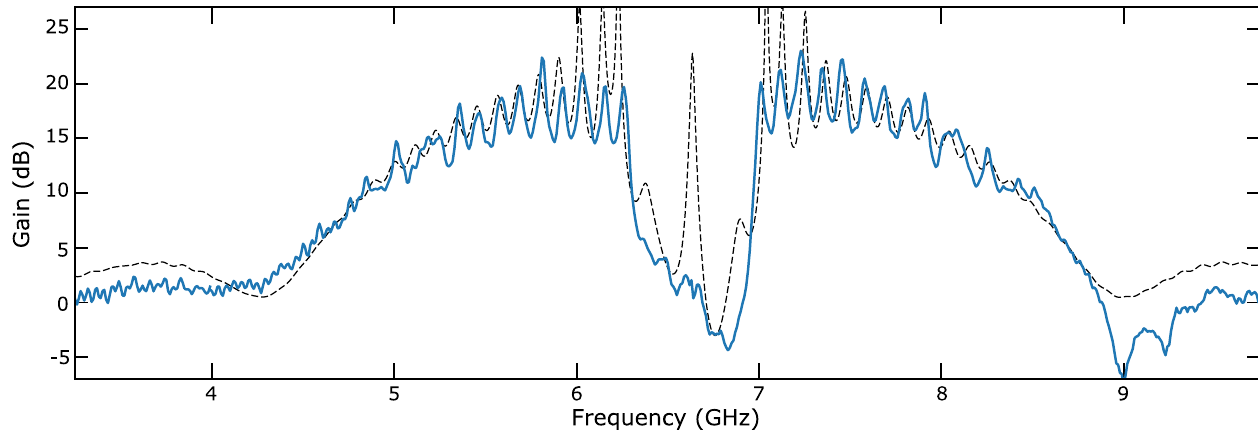
¼ − 117 dBm. s ¼ − 70 . 2 input